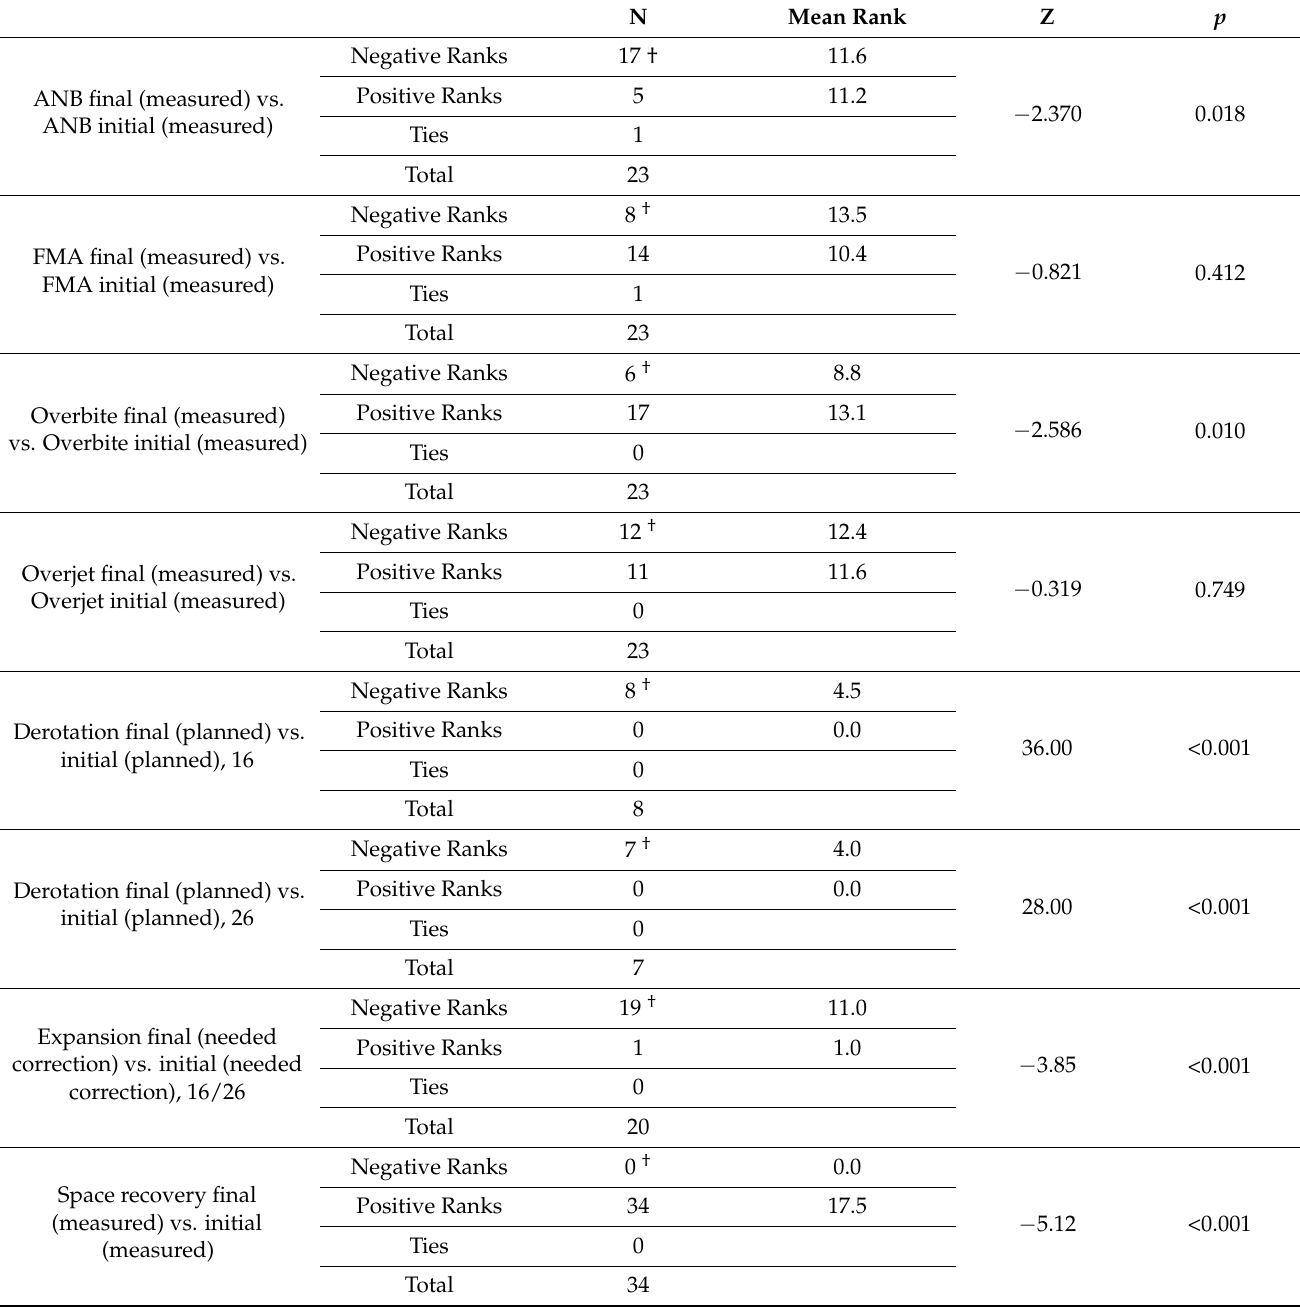
Table 5. The need for the improvement of the cephalometry parameters (from ANB to overjet) in relation to the reference values was compared at the beginning and at the end of the treatment. The need for correction on derotation, expansion, and space recovery metrics, comparing planned with actual measured values, was also assessed at the beginning and end of the treatment. The Wilcoxon signed-rank test was used to evaluate the progressions. N Mean Rank Z